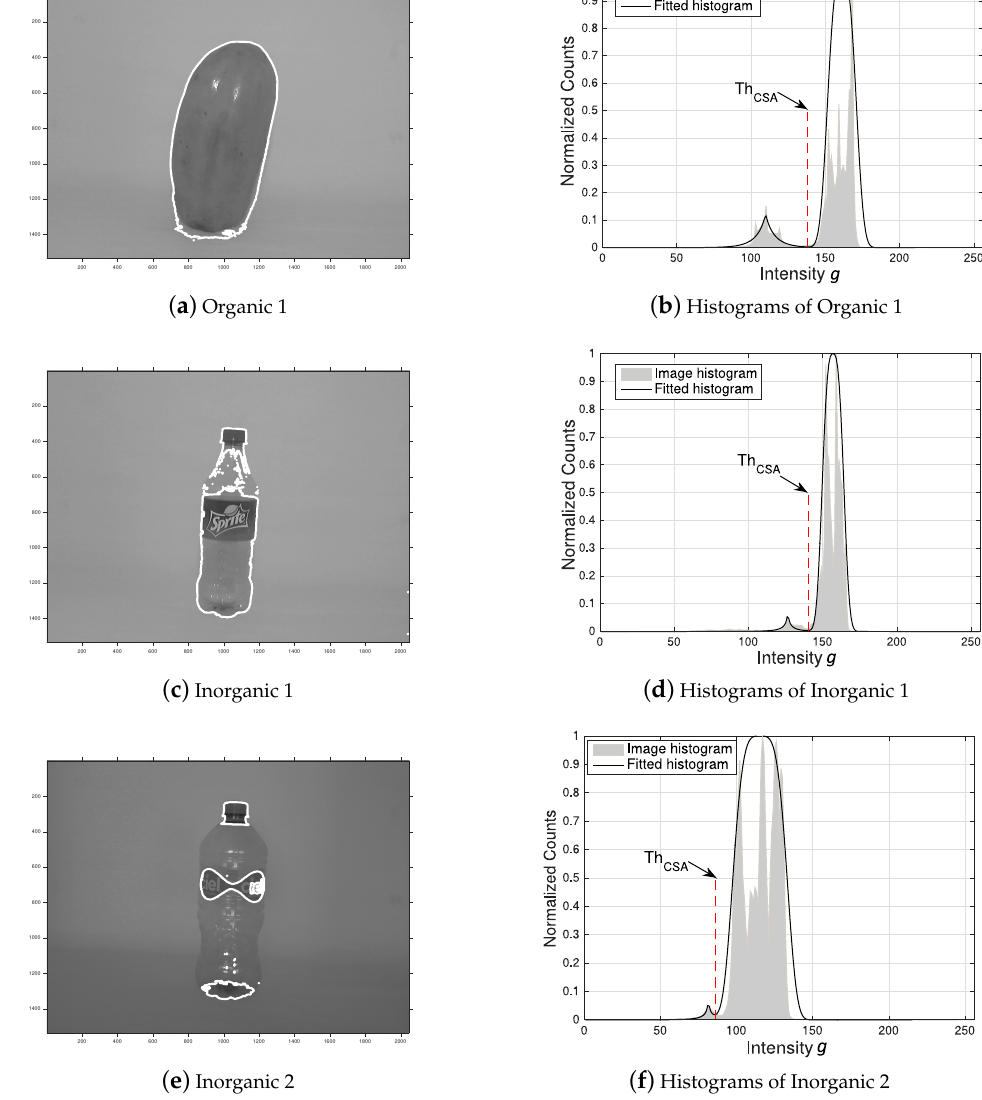
Figure 6. Illustrative example of the proposed algorithm implemented on three images, with quasi- modal histograms, containing either organic or inorganic products. Left column: gray-scale images and achieved detected outlines. Right column: image and fitted histograms and detected